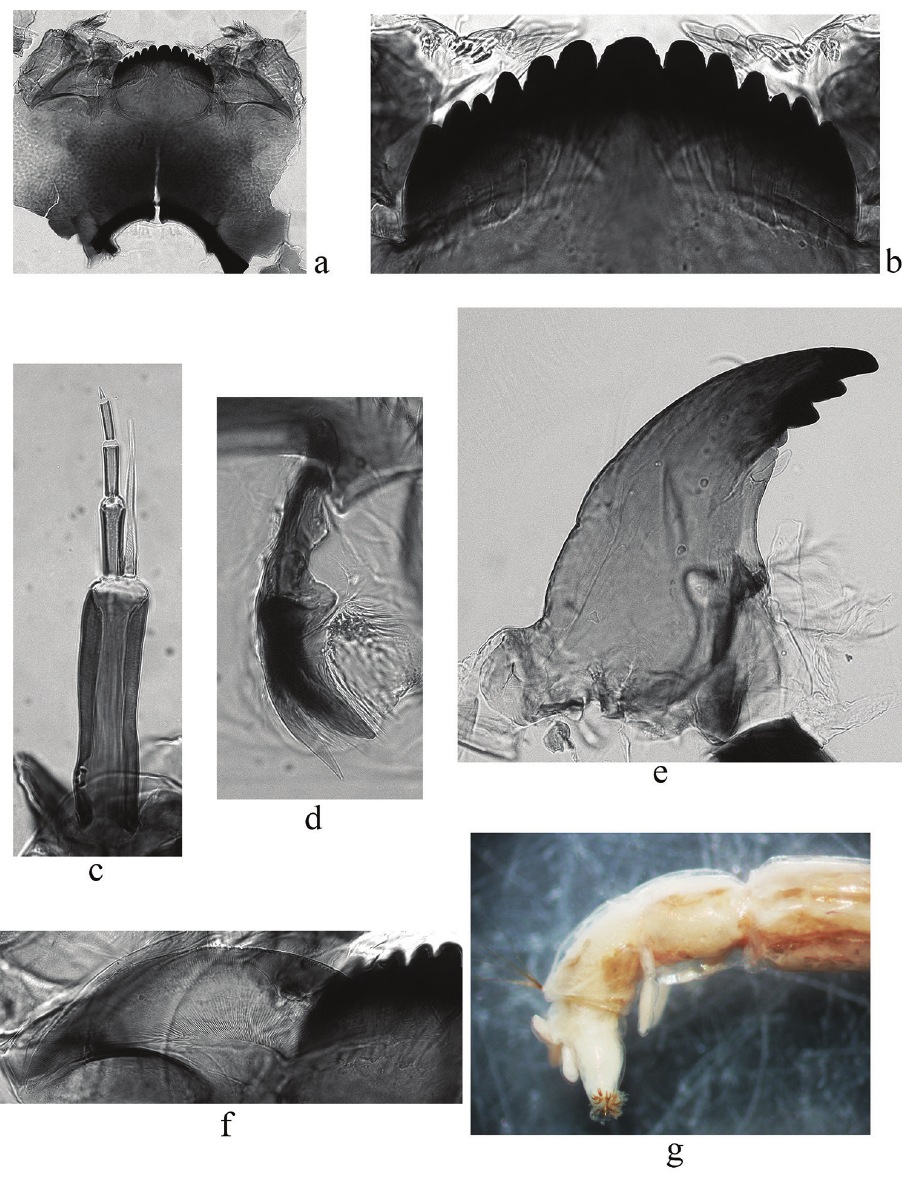
Figure 1. The larva of G. salinus from Tambukan Lake. a gular sclerite b mentum c antenna d premandible e mandible f ventromental plate g ventral tubuli on segment